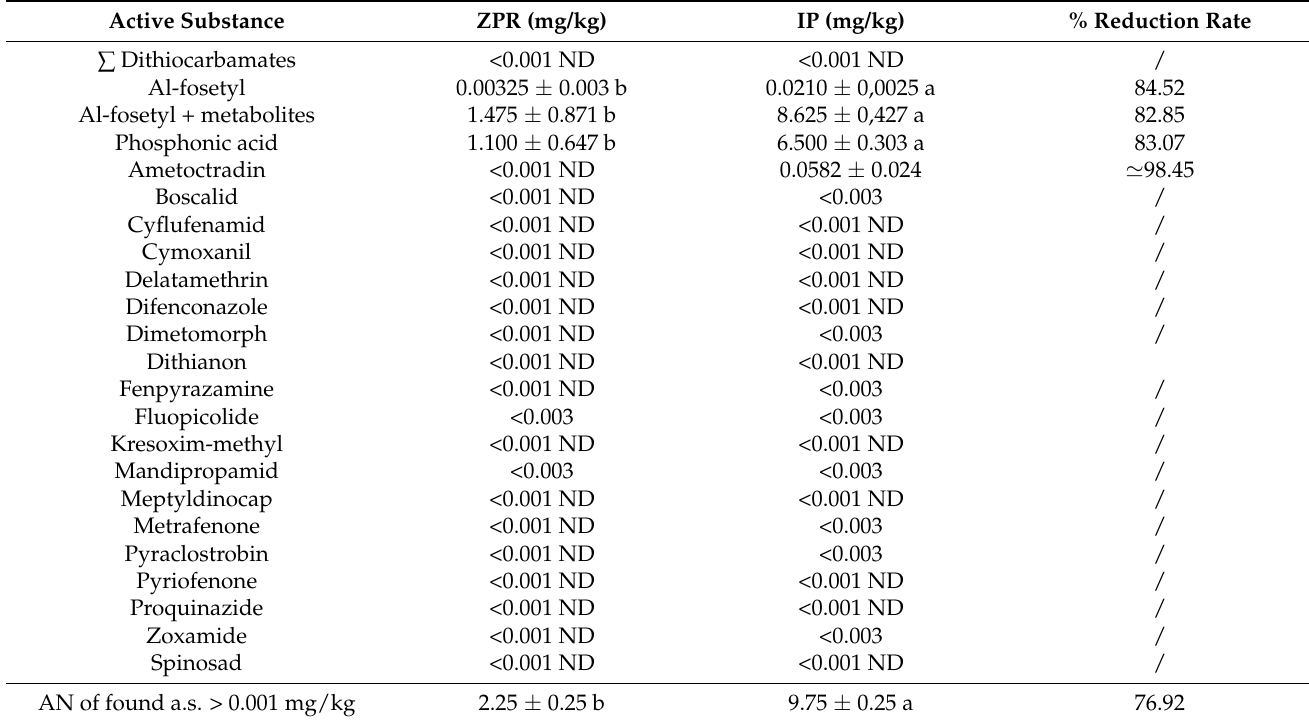
Table 15. Average concentration (mean ± SE) of pesticide residues in Merlot wine. A result of <0.001 ND means that a.s. was not detected at a level higher than 0.001 mg kg − 1 . /—concentration reduction rate and significance of difference between IP (integrated) and ZPR (0-pesticide residue) means cannot be calculated. Pesticide concentration reduction rate (%) = 100 − ((ZPR/IP) × 100) (see explanation in Section